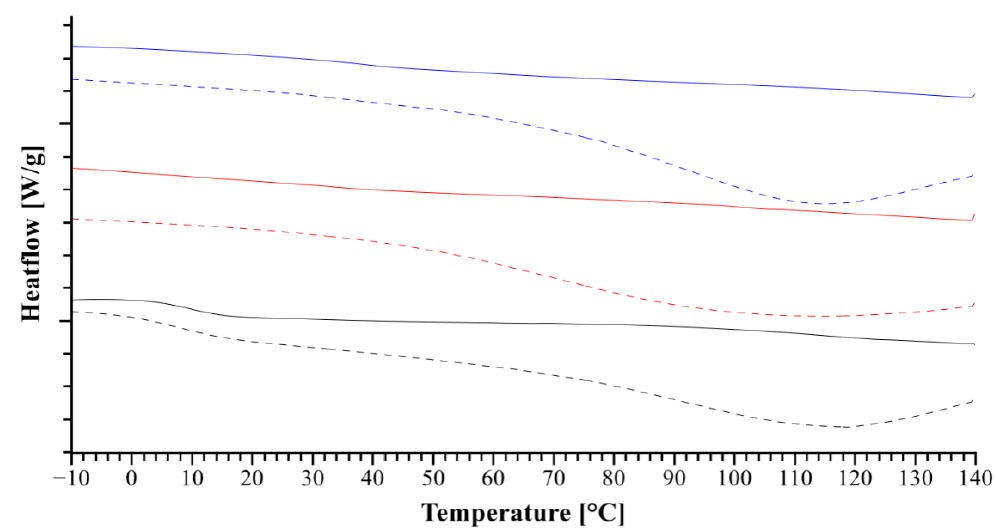
Figure 6. The solid lines represent the thermograms of the extrudate and the dotted lines represent the evaporates, which were used for the later extrusion. The additives used in addition to NaCMC are meglumine (black), TRIS (red) and urea (blue).